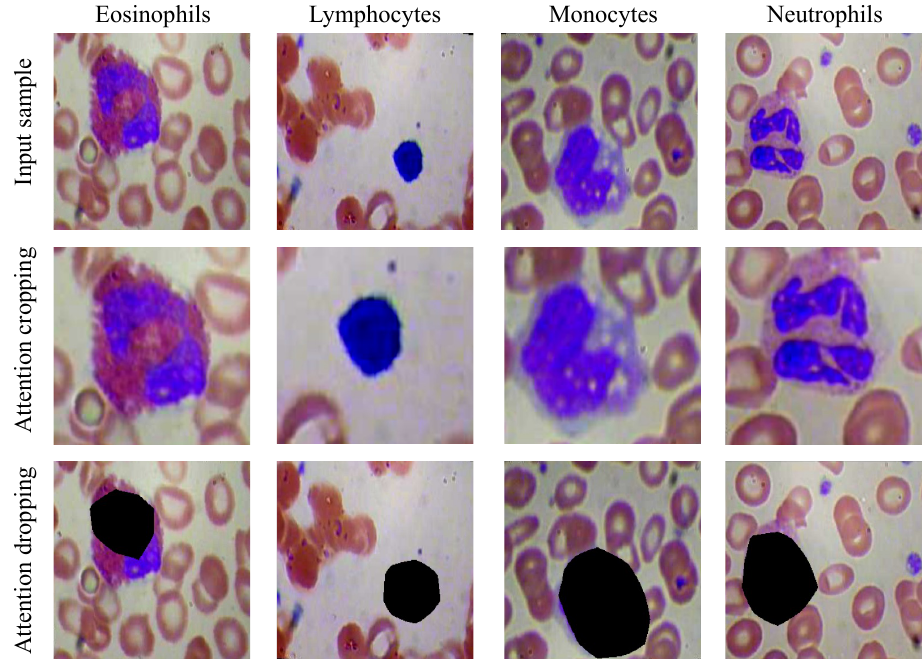
Figure 5. The obtained attention maps could be utilized to force the model to focus on different regions of the input image for more discriminative feature extraction. First, it is forced to pay more attention to regions with high attention scores through input image cropping. Second, the model is encouraged to explore different regions of the image by dropping regions with high attention scores.